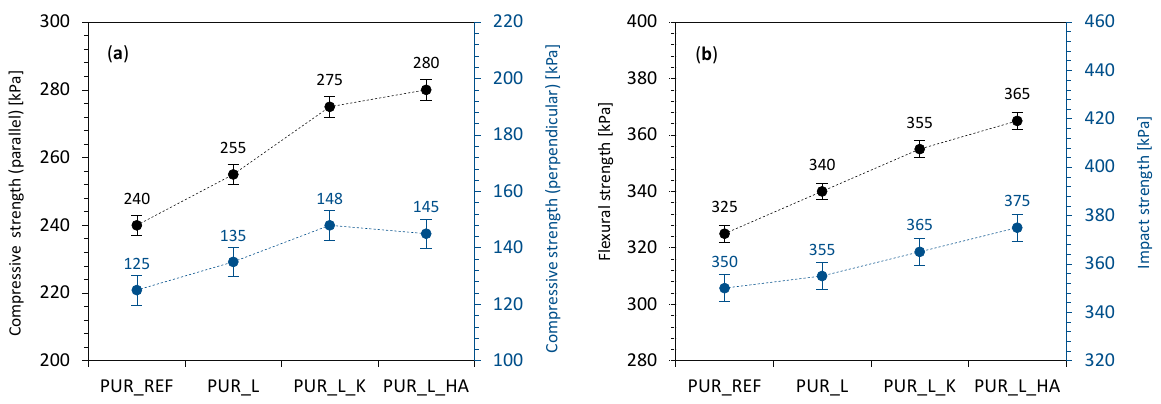
Figure 8. The mechanical performances of PUR foams—( a ) compressive strength, ( b ) flexural and impact strength.